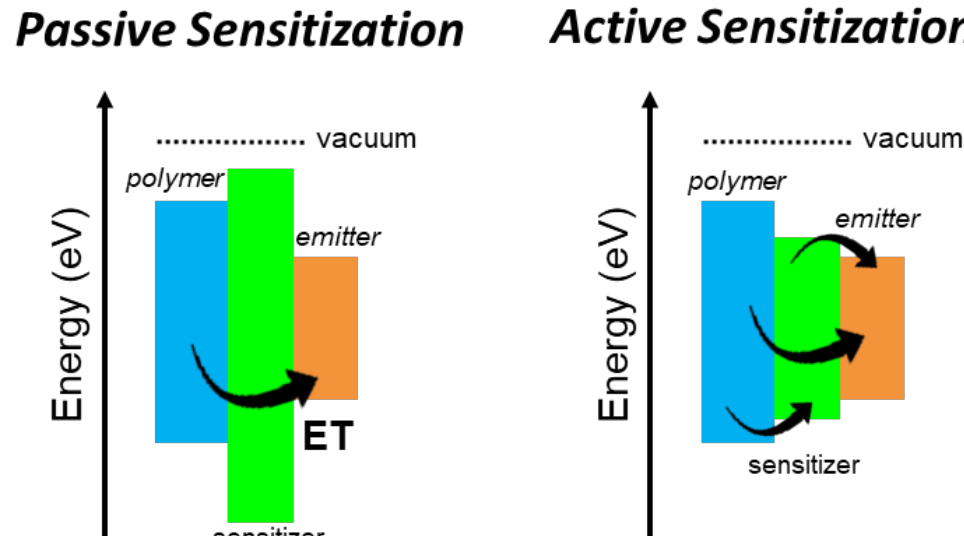
Figure 4. Outline of the energetics in an example multicomponent composite scintillator exploiting passive and active sensitization, respectively. The black arrow highlights the energy transfer processes (ET) that activate the luminescence of the emitter moiety.